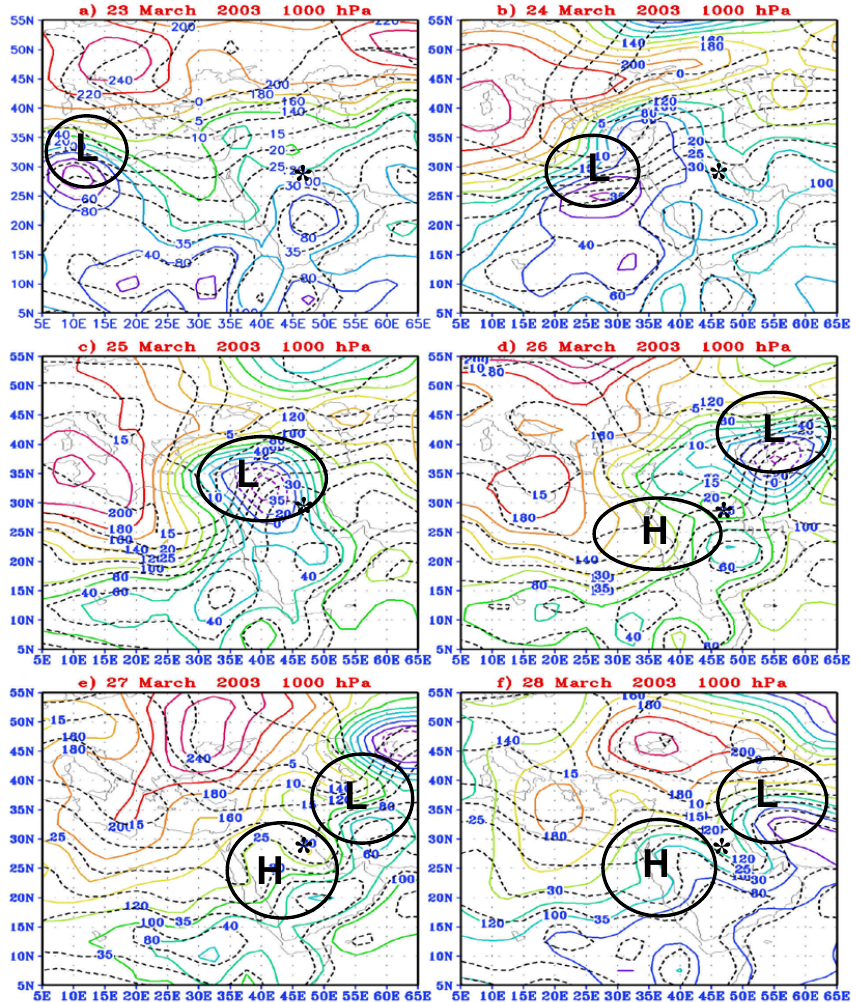
Fig. 2. Contour lines (solid lines) and isotherms (dotted lines) at 1000mb for the period of 23–28 March. The ellipses and circles show the low (L)- and high (H)- pressure zones. The star symbol ( ∗ ) indicates the location of